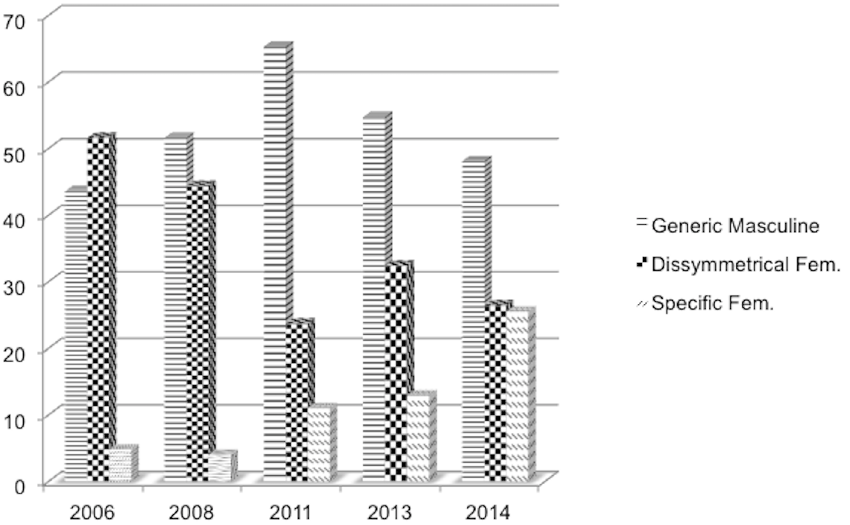
Figure 3. Trends of linguistic sexism/non-sexism markers in percentage terms for the women ministers of the five governments